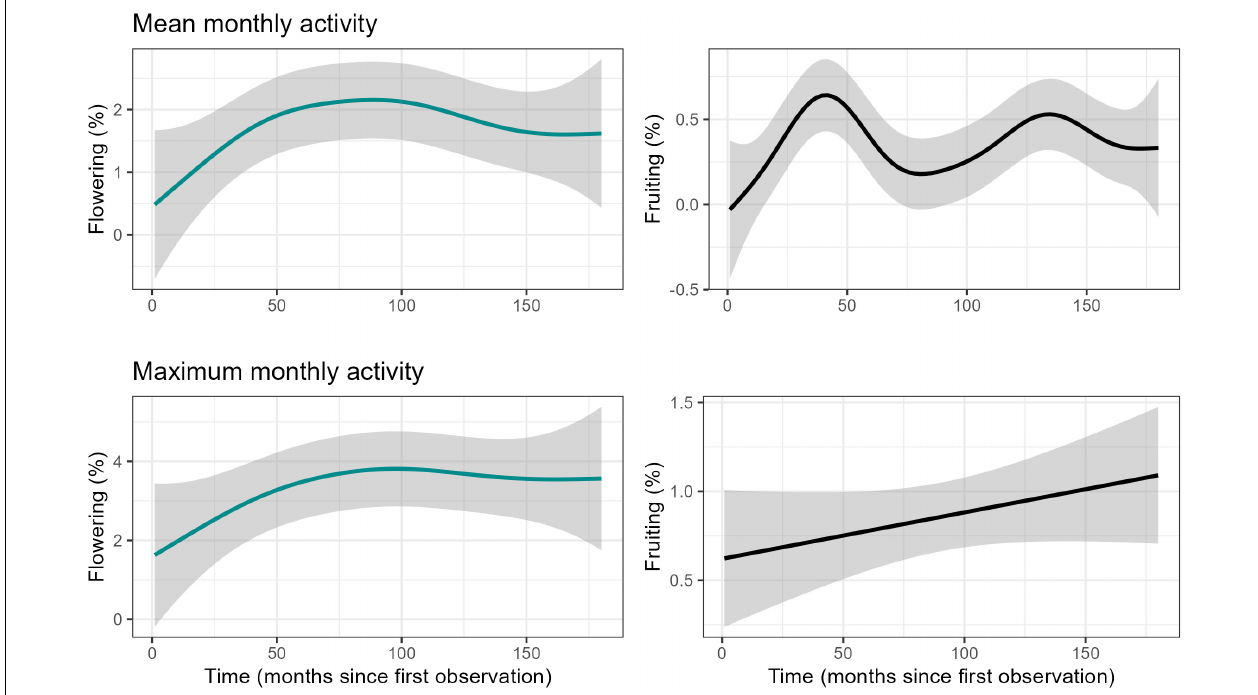
FIGURE 3 | Fitted GAM-smoother for long-term relationship between monthly mean and maximum phenological activity and time (months since first observation), for the liana community in Barron Gorge National Park, Far North Queensland,